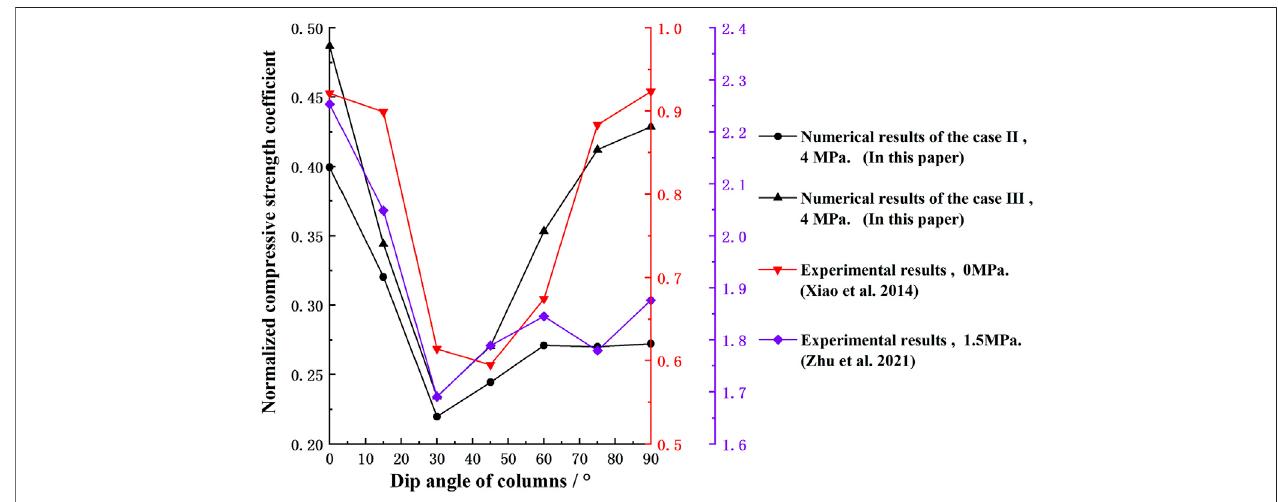
FIGURE 15 | Comparison between the numerical test results and laboratory physical test results of columnar jointed basalts (CJBs) (cases II and III correspond to the case between plane stress and plane strain and the case of plane strain, respectively).